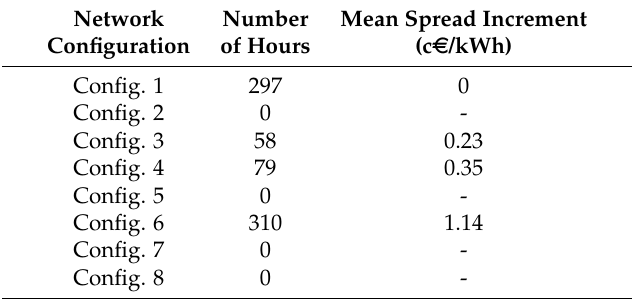
Table 1. The distribution of hours in March 2016 across the main